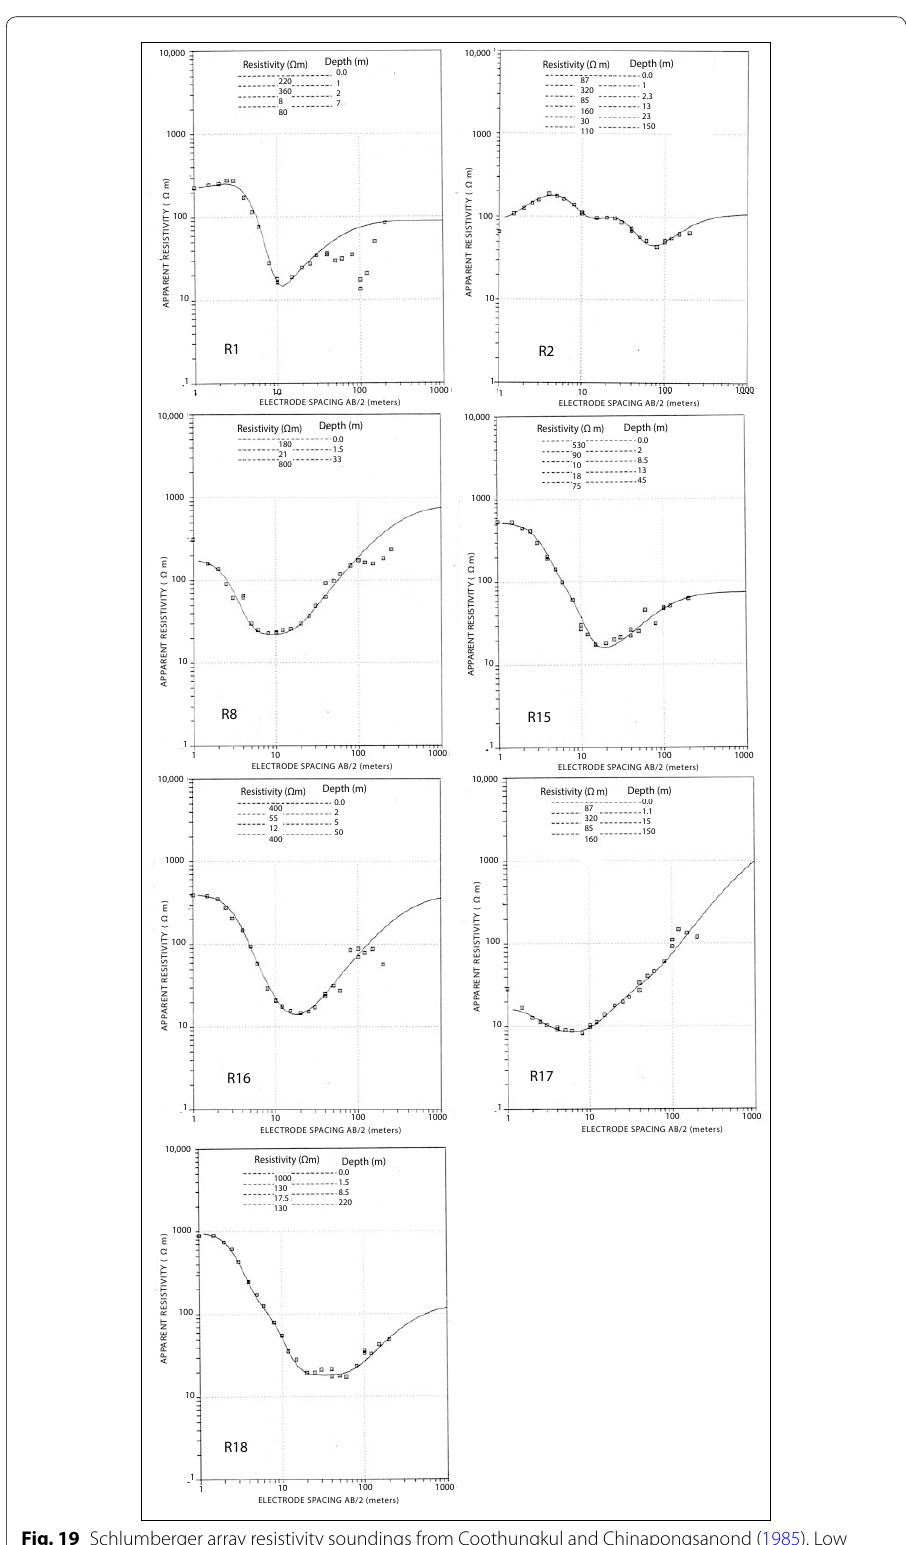
Fig. 19 Schlumberger array resistivity soundings from Coothungkul and Chinapongsanond (1985). Low apparent resistivity (< 60 Ωm) occurs in a zone 9–60 m depth on most soundings. Location of soundings shown by the X symbol in Fig.